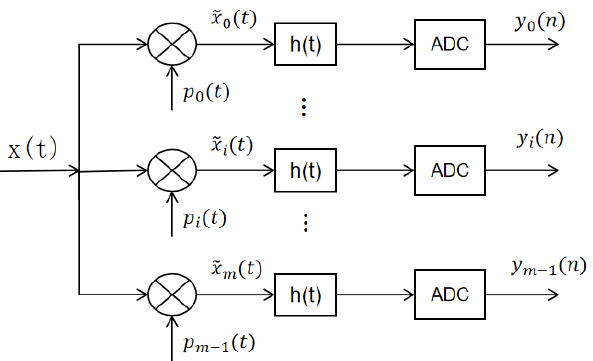
Figure 1. Multi-channel Random Demodulation Sampling